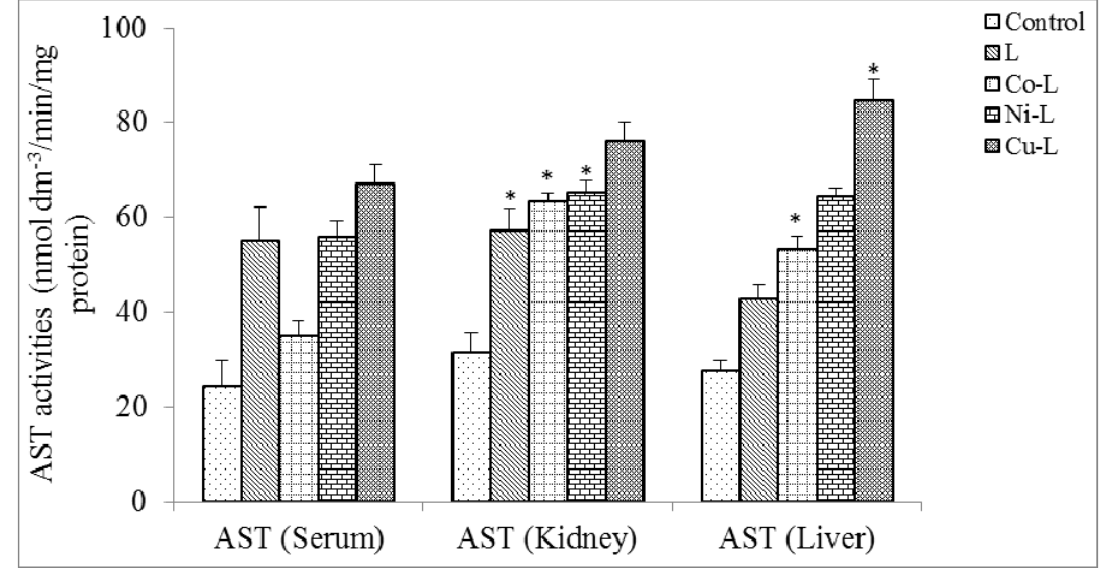
Figure 6. Effect of administration of ligand and the metal complex on the activities of aspartate amino transferase (AST) of rat serum, kidney and liver. * Significantly different from the control (p <